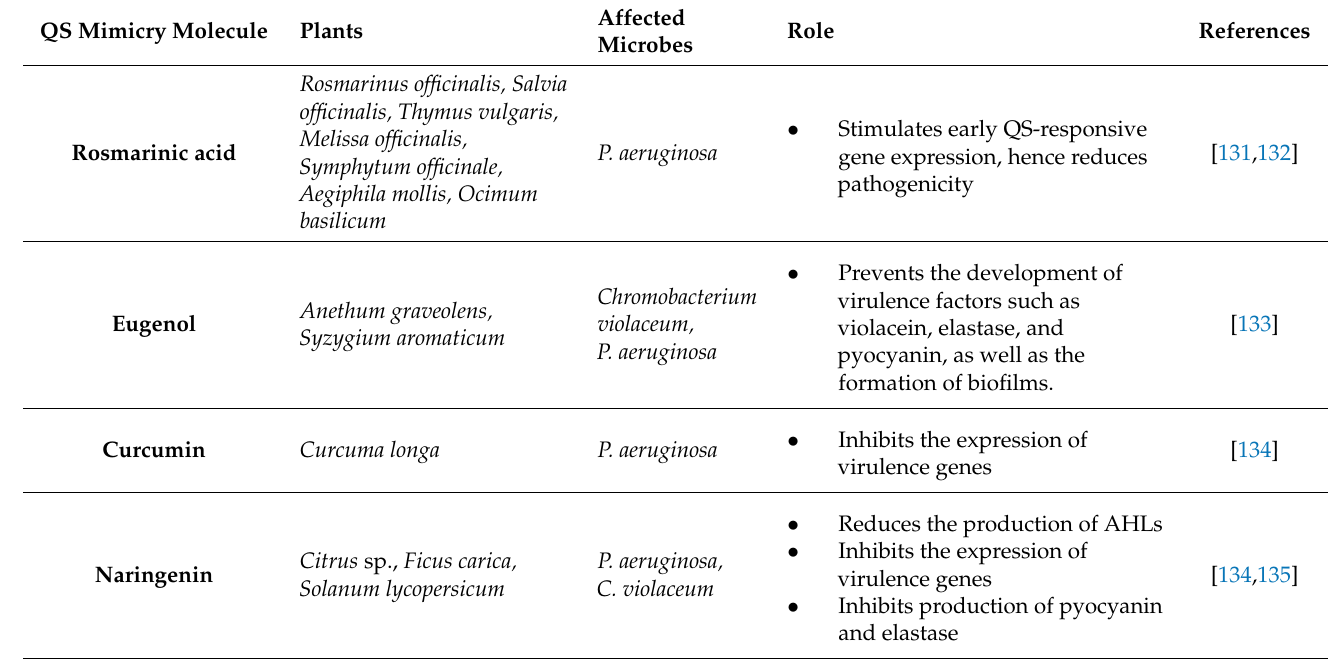
Table 3. Plant quorum sensing mimicry molecules and their effect on